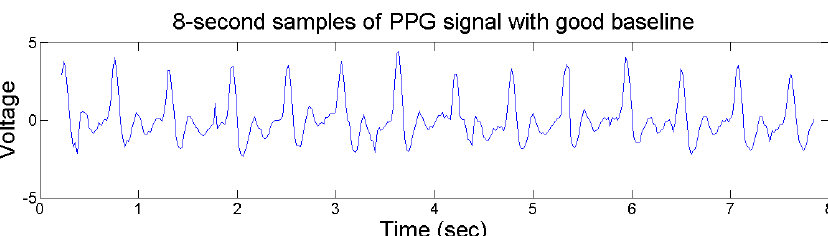
Figure 5. Typical plots of PPG signal with good baseline.